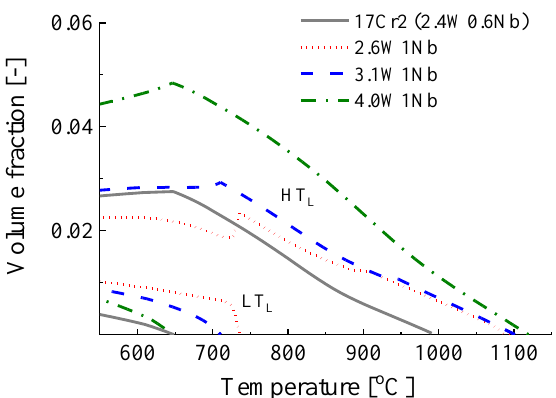
Figure 1. Phase volume fraction of the high W / high Nb trial alloys in comparison to the HiperFer 17Cr2 [9–12] prototype alloy (calculated utilizing the commercial software package Thermocalc ® , database: TCFE7).